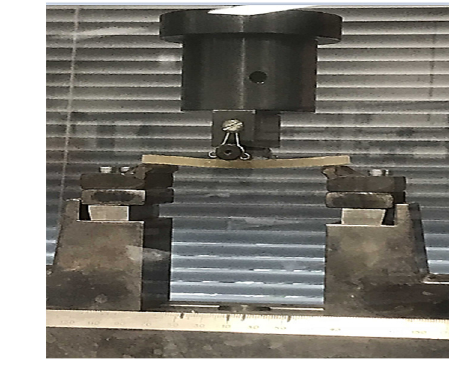
Figure 10. The flexural testing of GFRE samples.